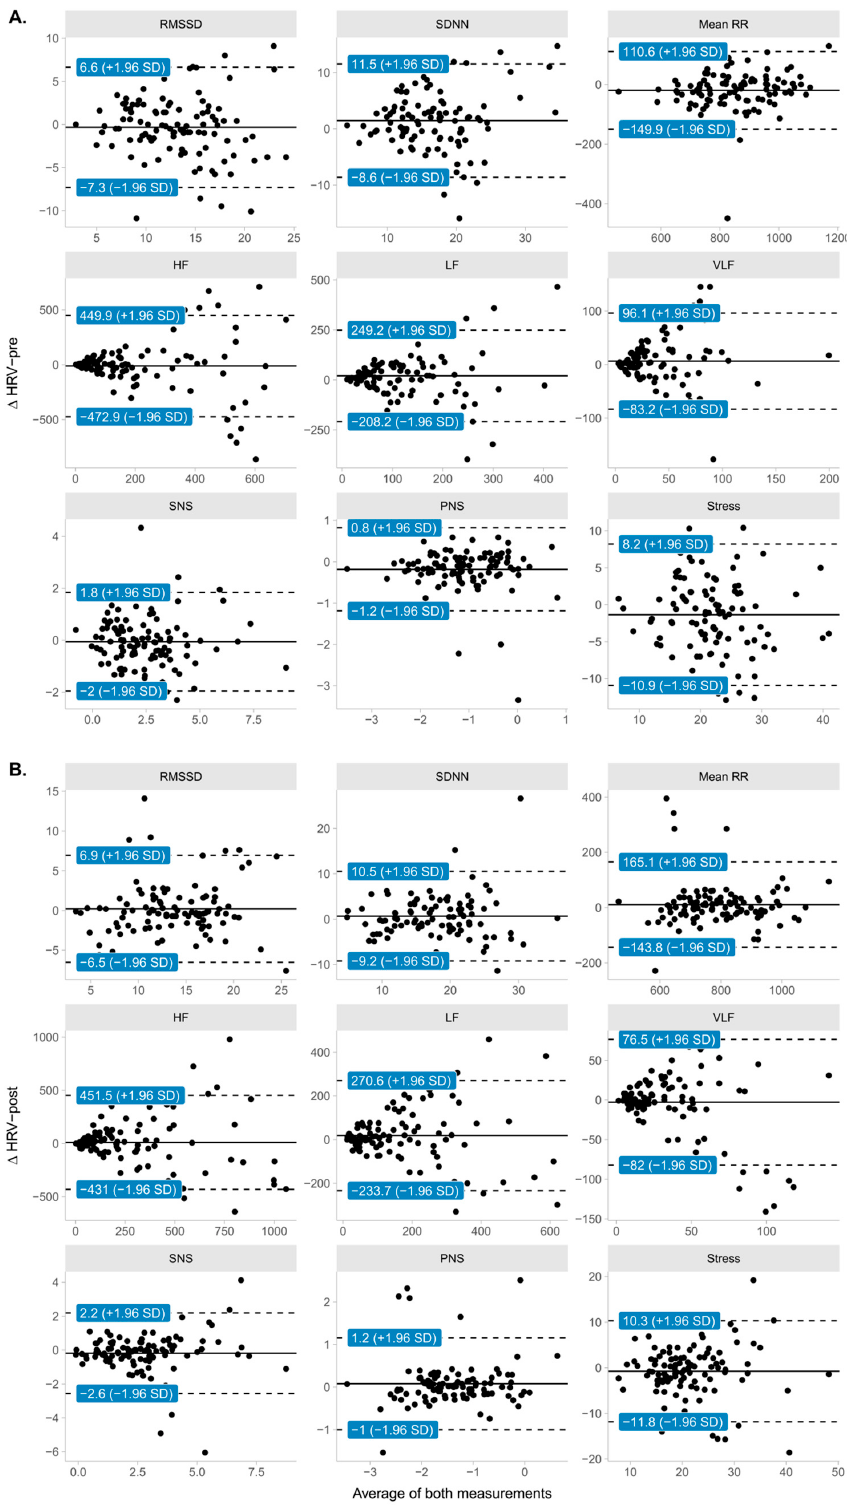
Figure 4. Bland–Altman plots and 95% limits of agreement between pairs of measurements in correlative assessments relative to the application of the TMST. ( A ) Limits of agreement for HRV parameters pre-TMST; ( B ) Limits of agreement for HRV parameters post-TMST.